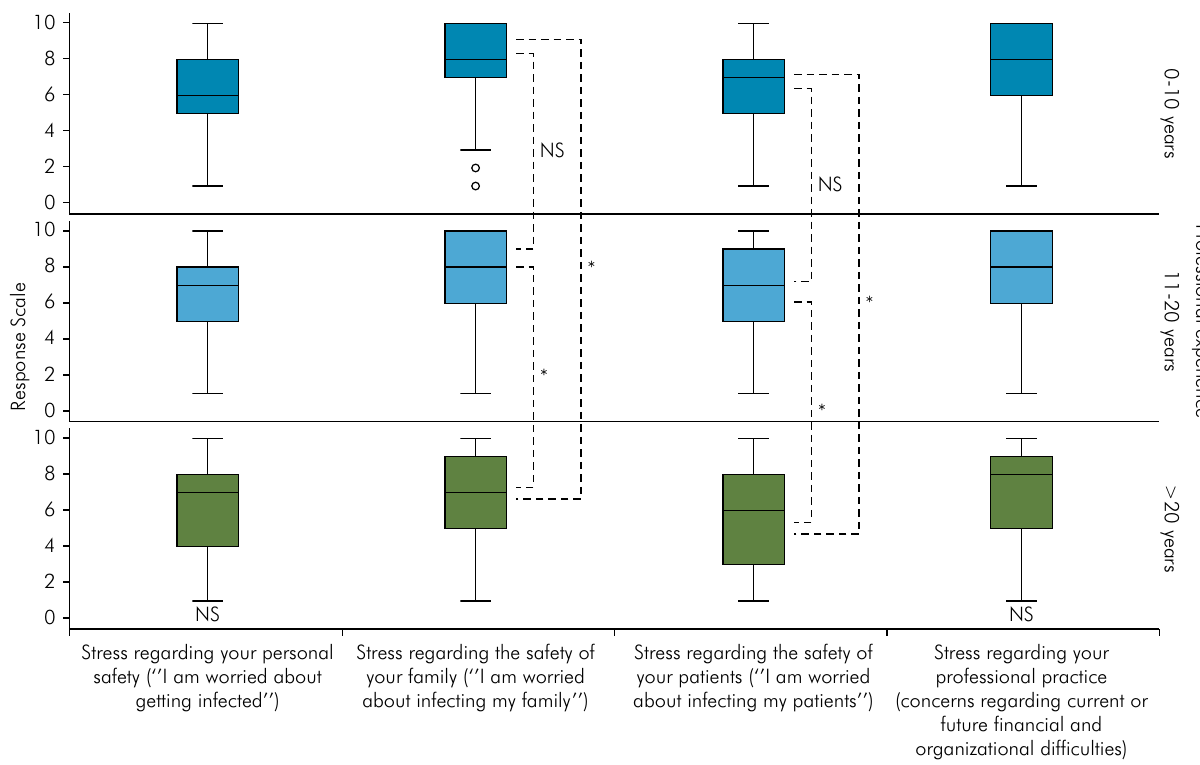
Figure 3. Box-plot representing the statistical relation of professional experience and stress scale responses. [Data represented as median (horizontal bars inside the box) and range (Y-error bars). * = represents significant difference (p < 0.05). NS = Non-significant (p >